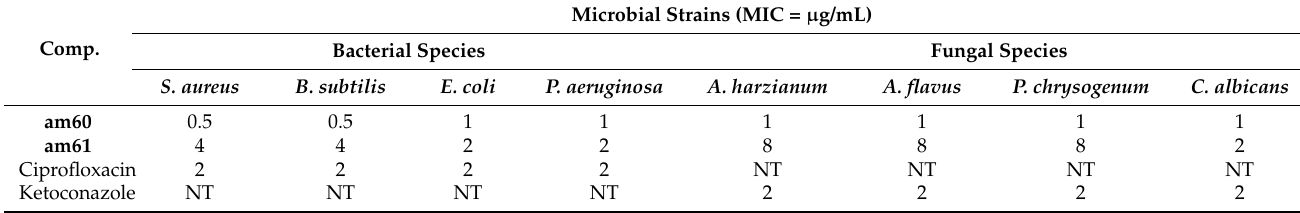
Table 28. Antimicrobial activity (MIC = µ g/mL) of the compounds ( am60 – am61 ).